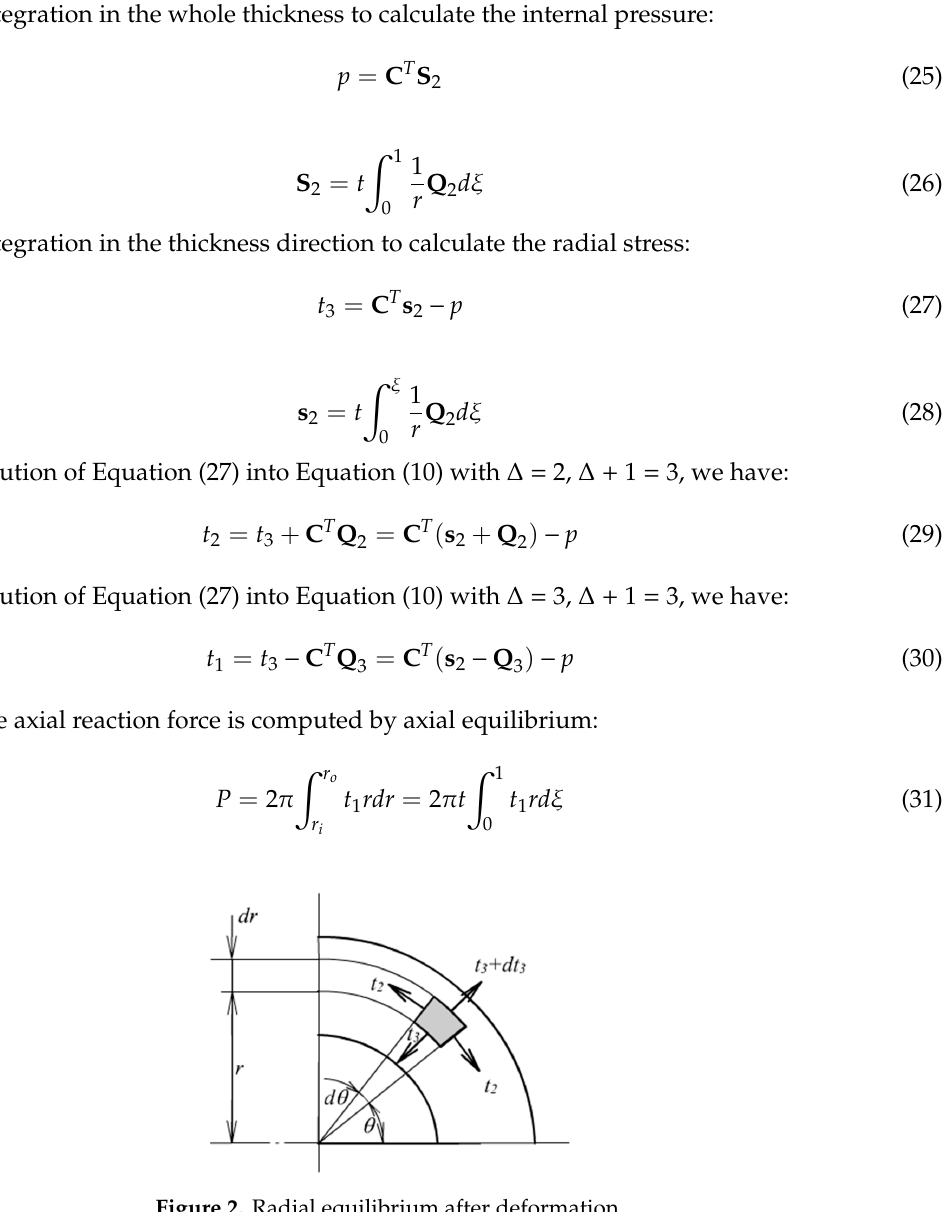
Figure 2. Radial equilibrium after deformation.